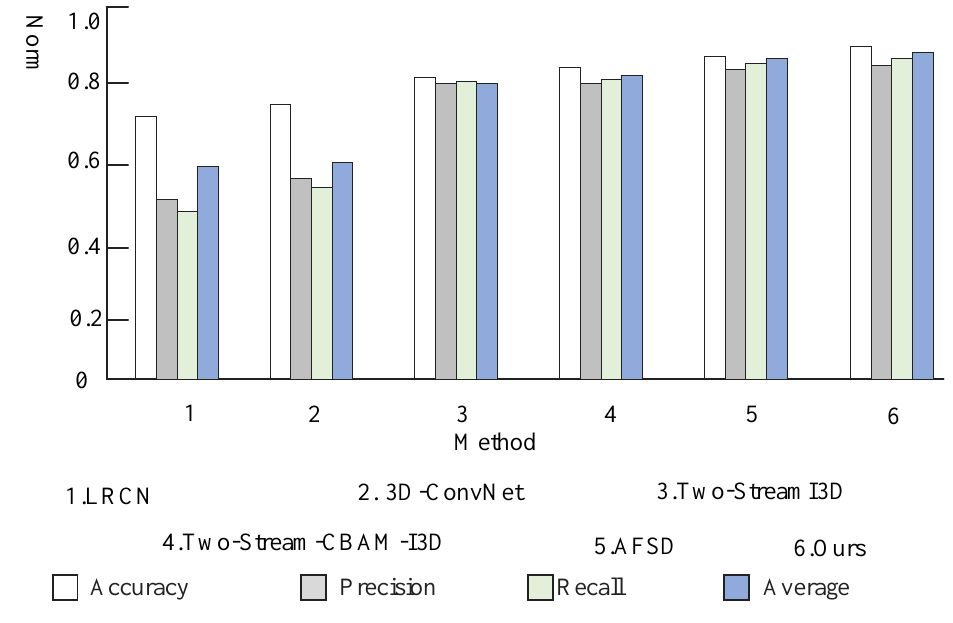
Figure 10. Performance comparison of action recognition.